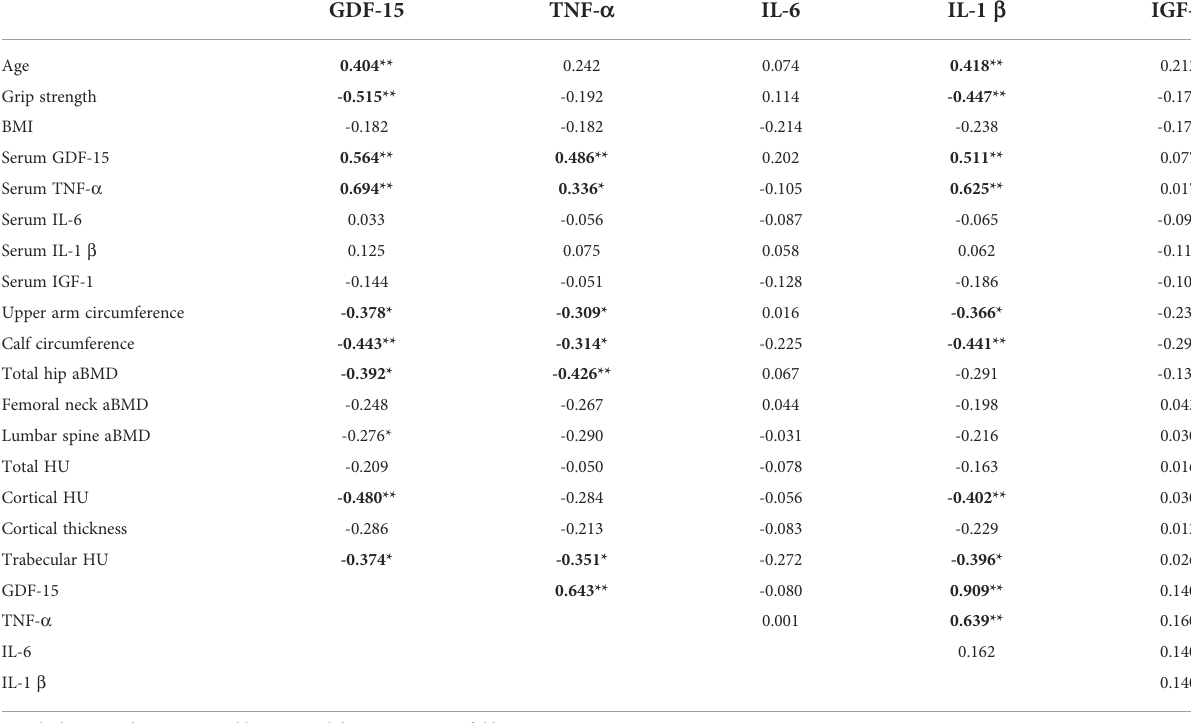
TABLE 6 Correlation among age, handgrip strength, BMI, circumferences of upper arm and calf, mRNA expression levels of GDF-15 and cytokine in muscles, aBMD of total hip, femoral neck, and lumbar spine, and local bone quality of radial